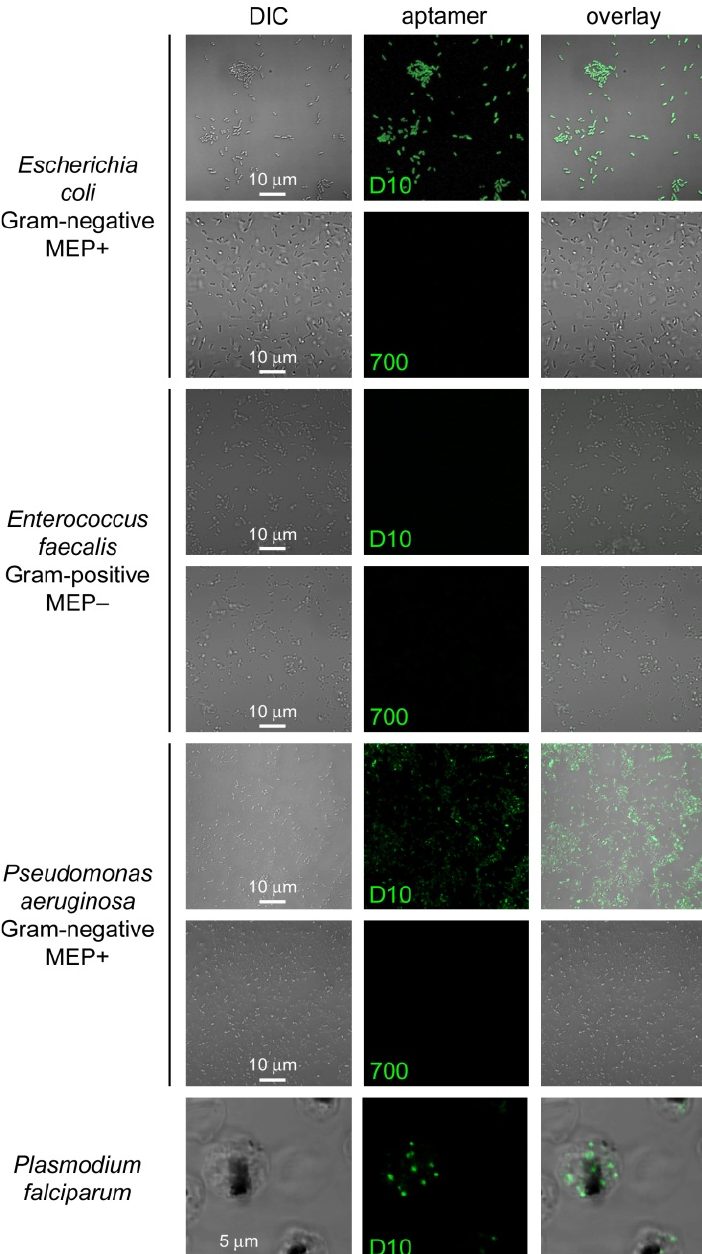
Figure 10. Fluorescence microscopy analysis of E. coli , E. faecalis , and P. aeruginosa cells treated with 1.2 µM 6FAM-labeled D10 aptamer. Positive and negative controls include the staining of P. falciparum with the same aptamer and the three bacteria species with an identical concentration of the 6FAM-labeled aptamer 700, respectively. DIC: differential interference contrast image.